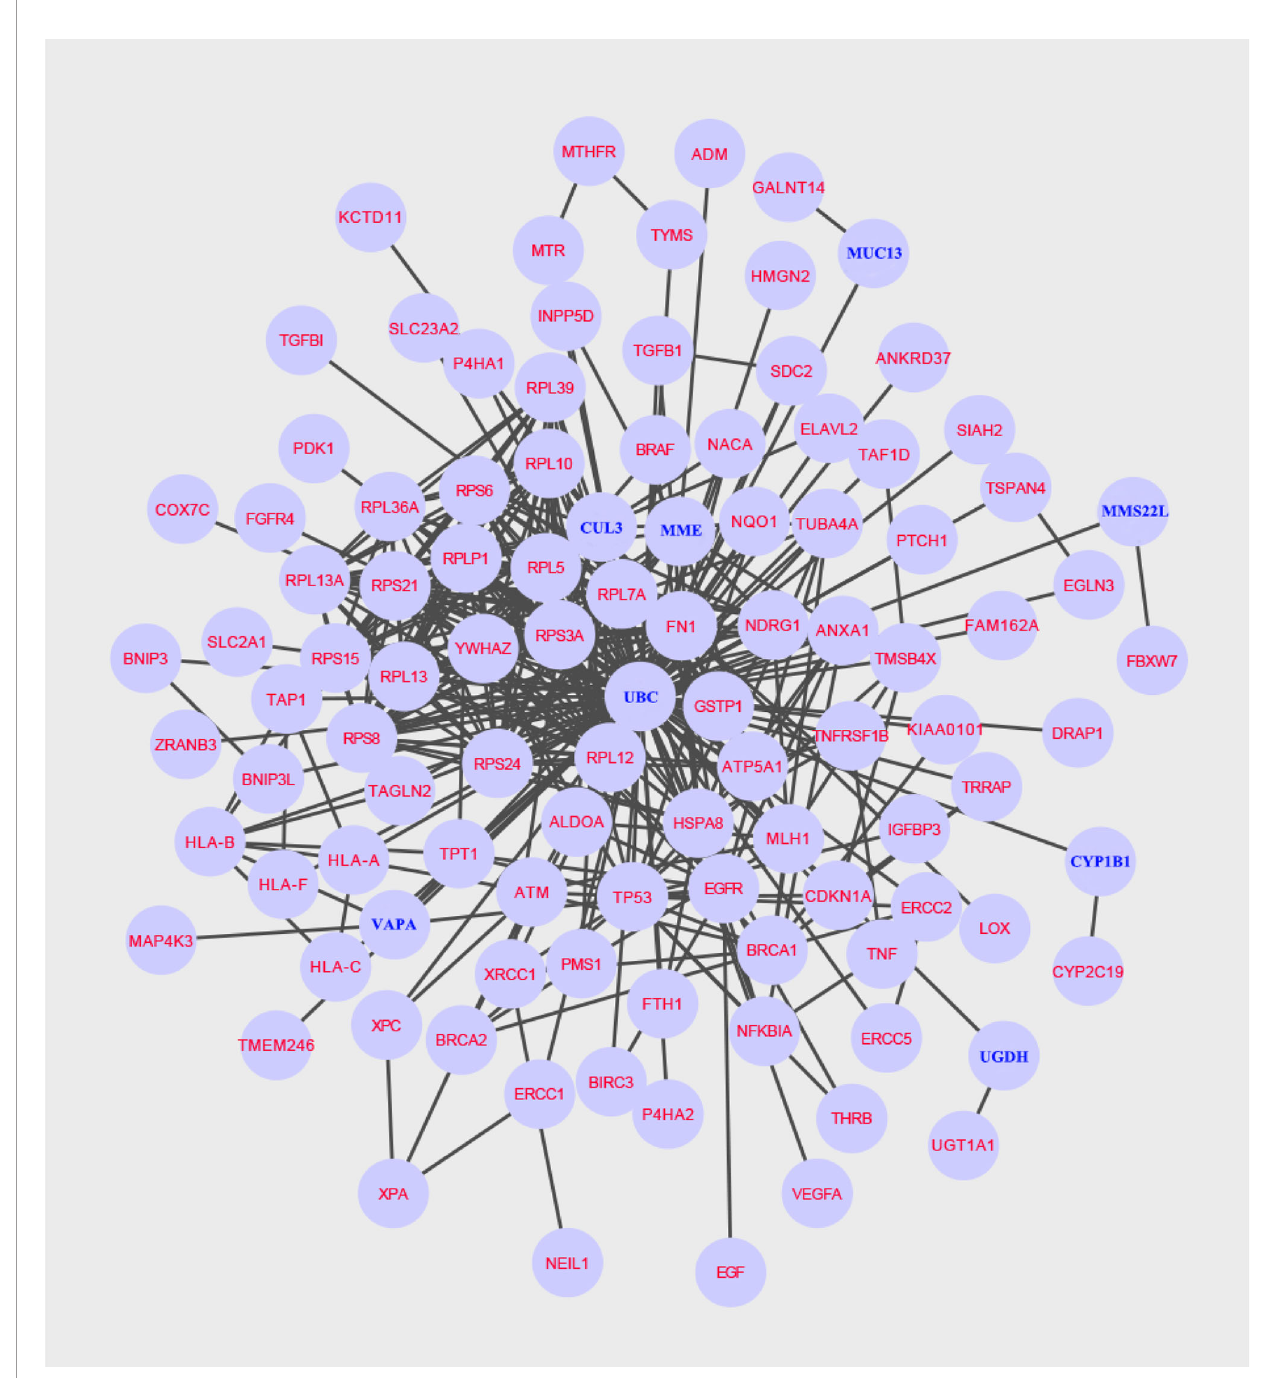
FIGURE 2 | A speci fi c protein network associated with NCRT ef fi cacy is built using the Steiner minimal tree algorithm, including 105 nodes and 379 edges. Additionally, eight new genes are labelled in